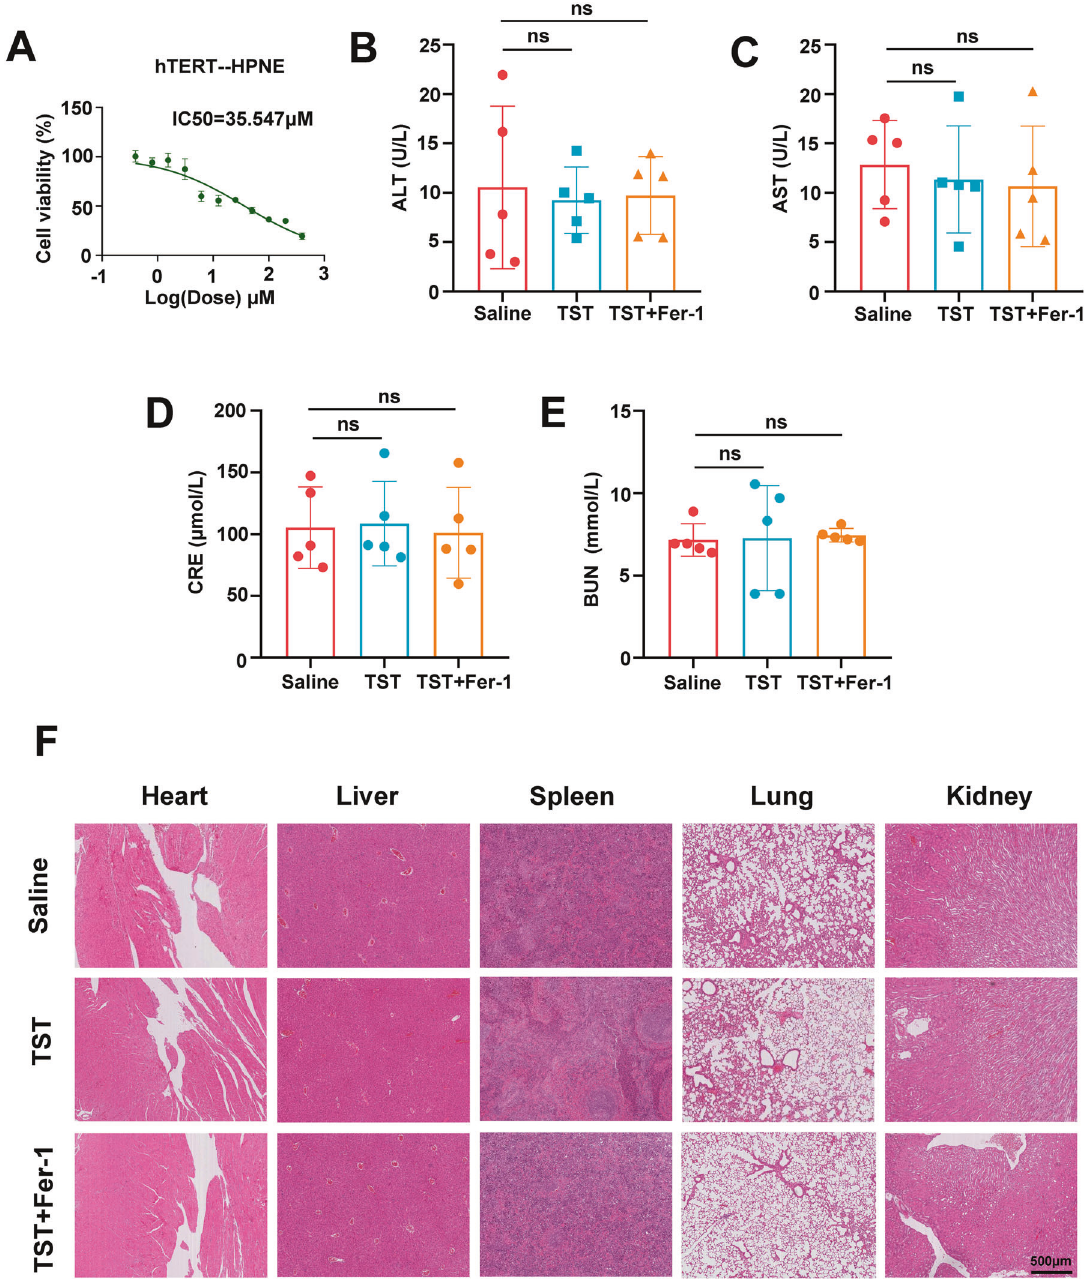
Fig. 6 The potential biosafety value of thiostrepton on tumour treatment. A hTERT-HPNE cells were treated with TST (0 – 250 μ M) for 48 h, and cell viability was determined using the CCK-8 assay. B and C Serum were collected, and the levels of ALT and AST, which are markers of liver function, in mice from different treatment groups were determined. D and E After different treatments, the levels of CRE and BUN, which are markers of renal function, were measured in mice. F HE staining shows the morphology of mouse heart, liver, spleen, lung and kidney from animals receiving different treatments (ns: not signi fi